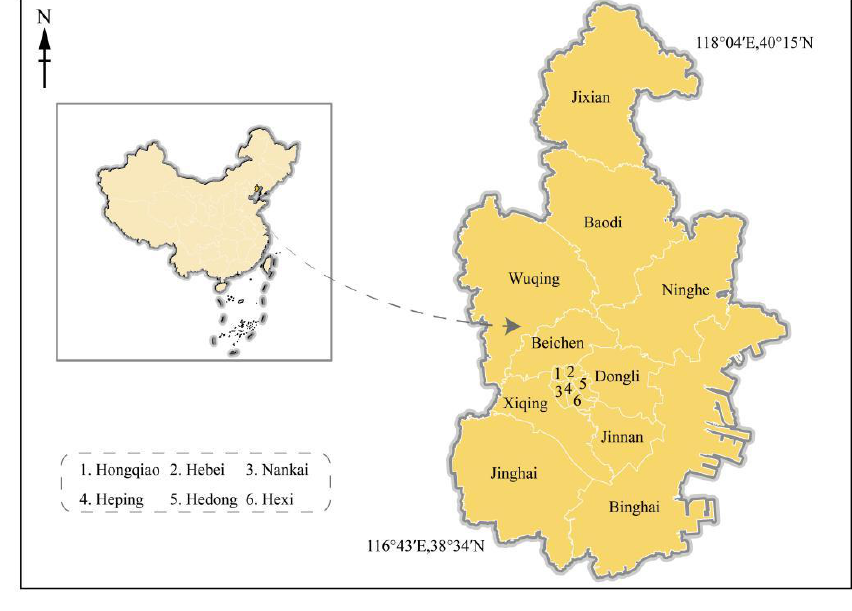
Figure 1. The study area.